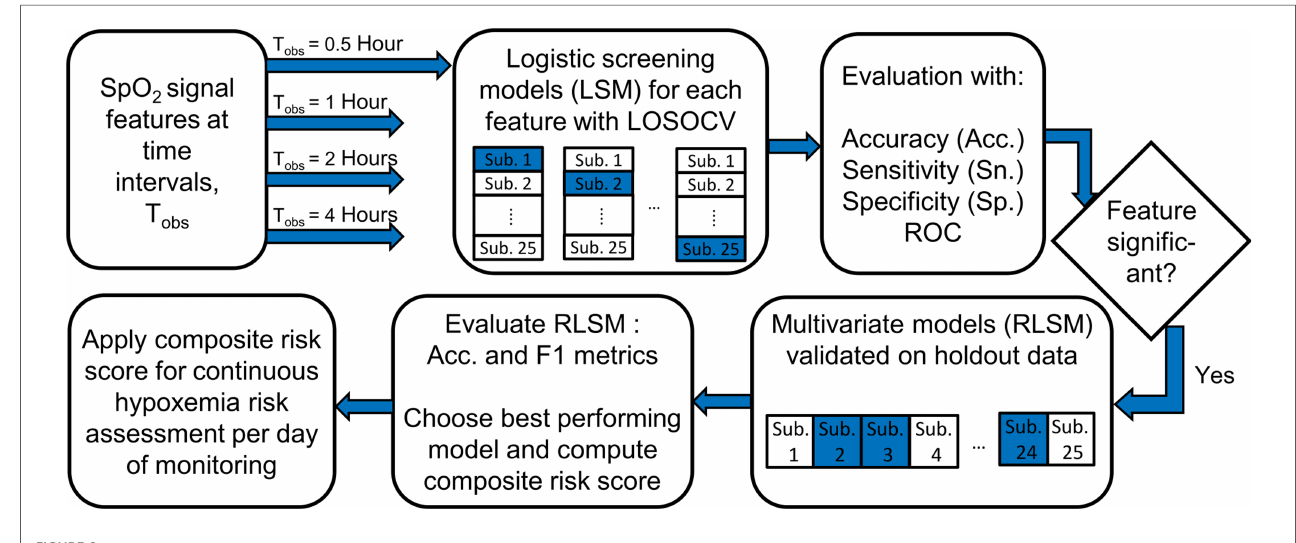
FIGURE 2 Schematic representation of intermittent hypoxemia (IH) risk screening methodology.